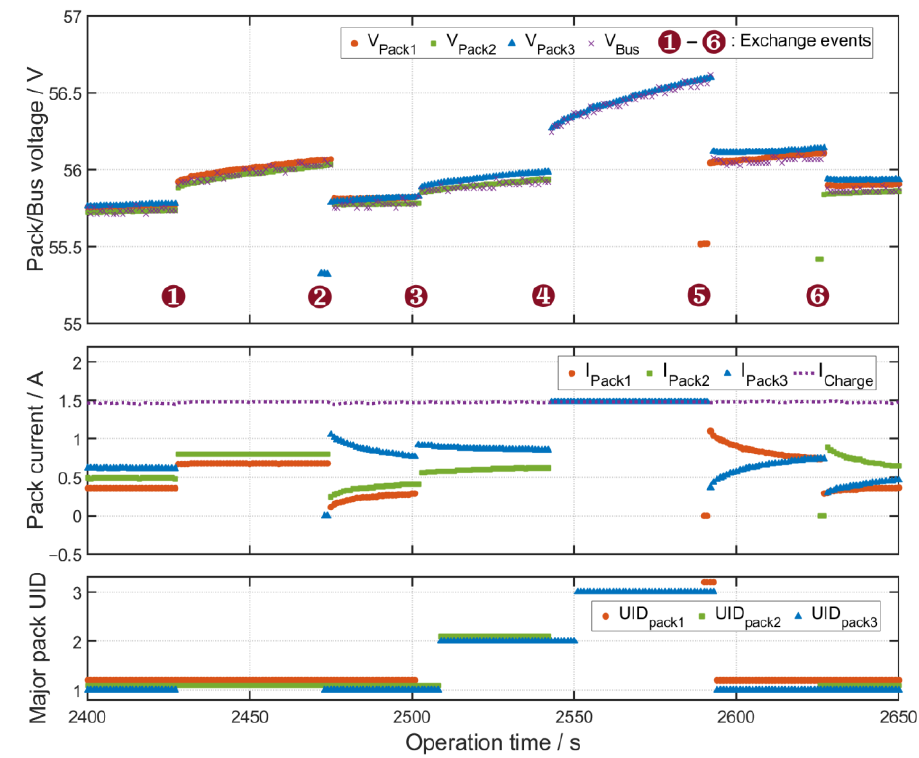
Figure 10. Enlarged view of battery pack insertion/removal events during charging.